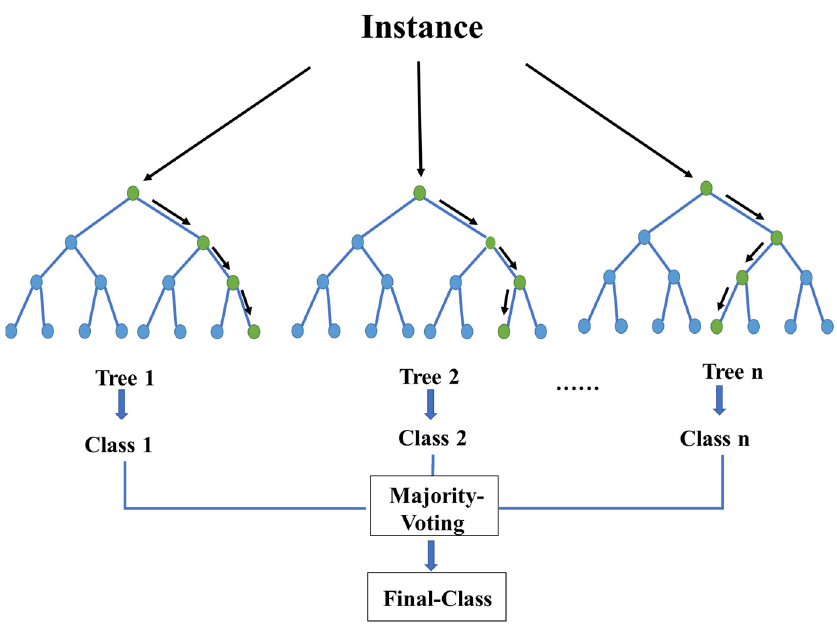
Figure 5. Schematic representation of the Random Forest principle.